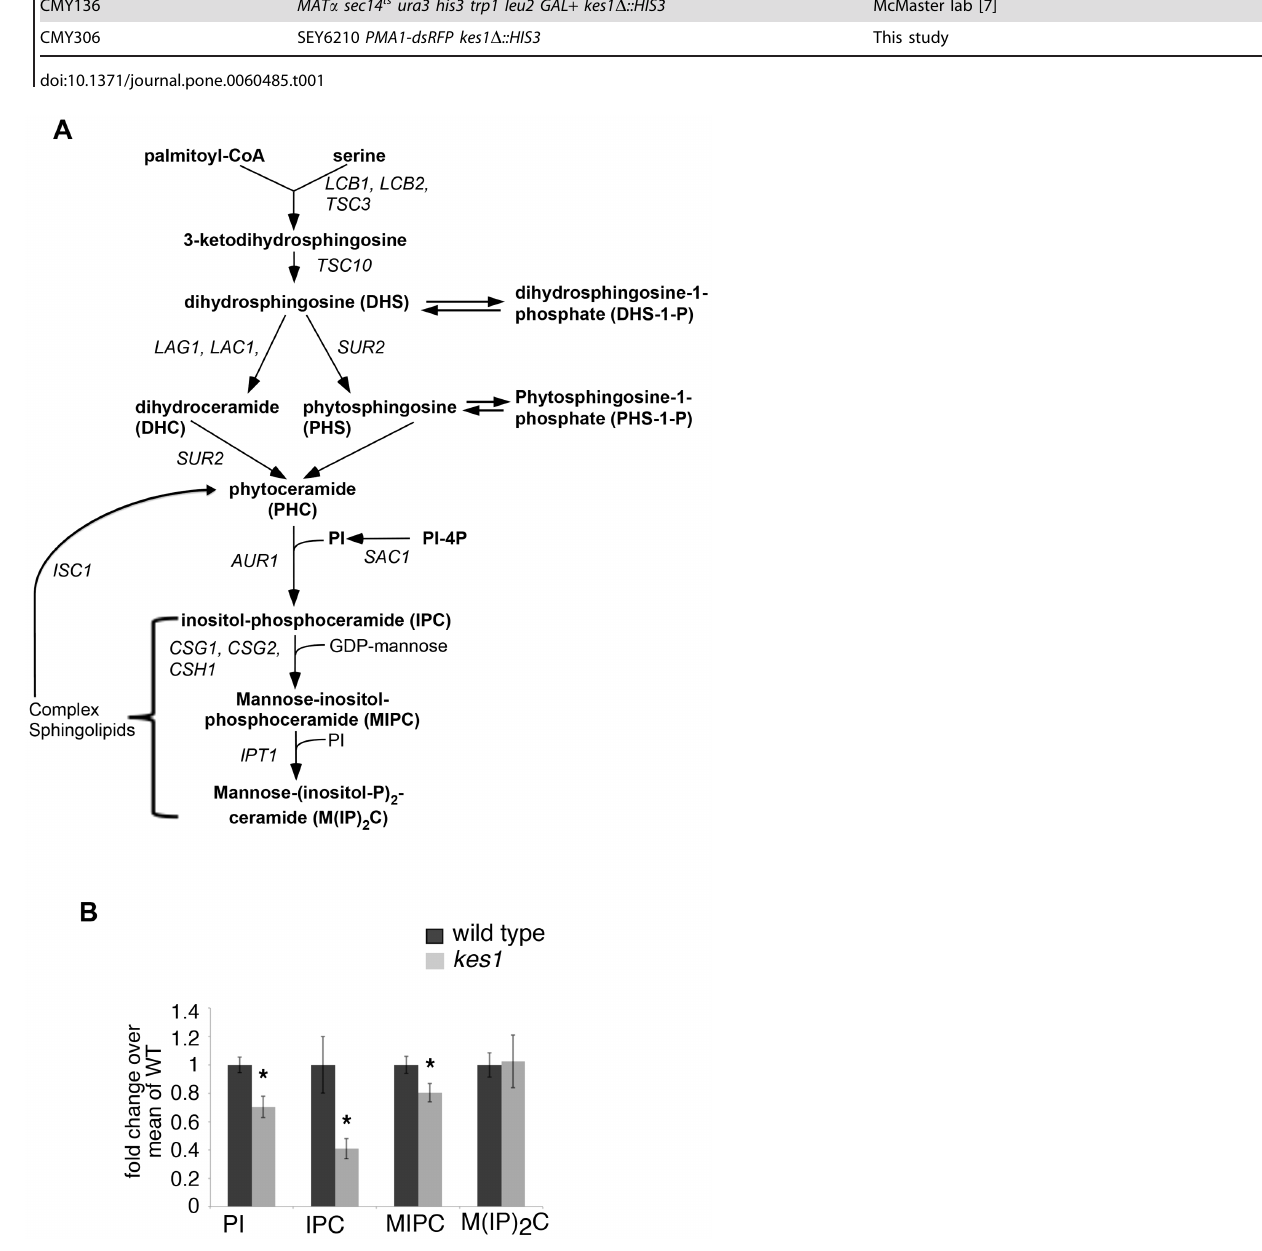
Figure 1. Kes1 enhances complex sphingolipid metabolism. (A) Phosphoinositides plays a central role in the synthesis of sphingolipids in yeast. Gene names are shown in italics. Metabolic intermediates and complex sphingolipids are shown in bold font. Inactivation of KES1 inhibits the synthesis of sphingolipids. (B) Cells were grown to late logarithmic phase and inoculated into medium containing myo -[ 3 H]inositol, grown to mid- logarithmic phase and lipids were extracted and resolved by thin layer chromatography. Radioactivity of the resolved lipids was measured for PI, IPC, MIPC and M(IP) 2 C. Values were normalized to cell number and are presented as fold-change over wild type. Data represent mean + / 2 SE of four independent experiments performed in triplicate. *P , 0.05 respective to control.